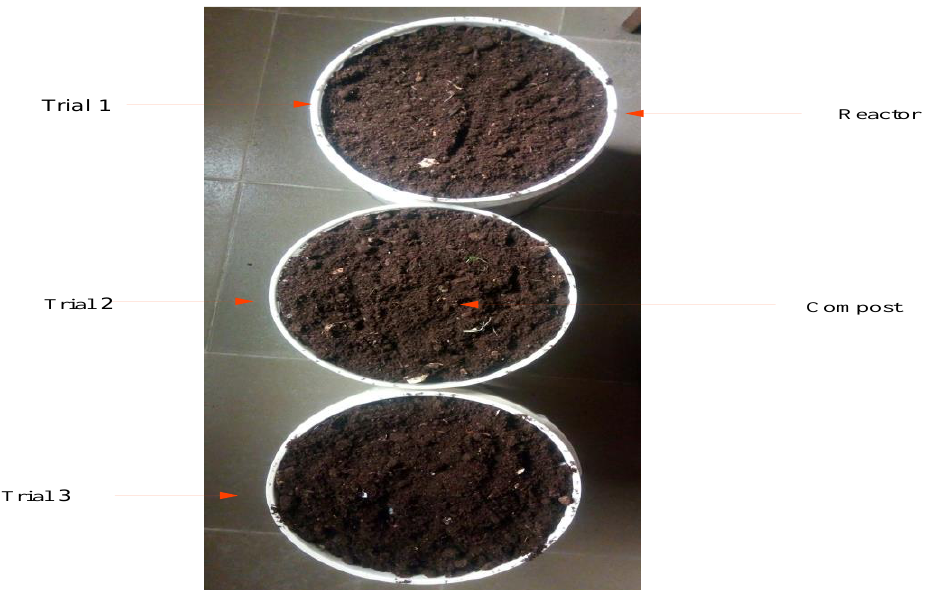
Fig. 2 Experimental setup overview of the reactor used in this study